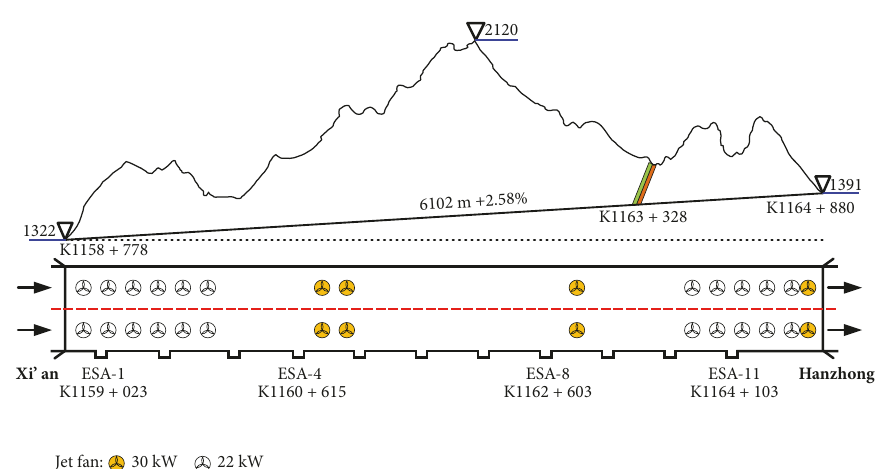
Figure 1: Qin Mountains tunnel group.